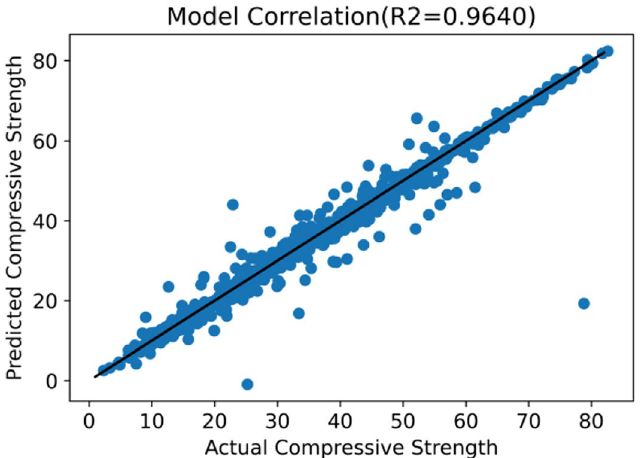
Fig. 15 Actual vs predicted for the concrete compressive strength ANN model (Model with physics loss function for